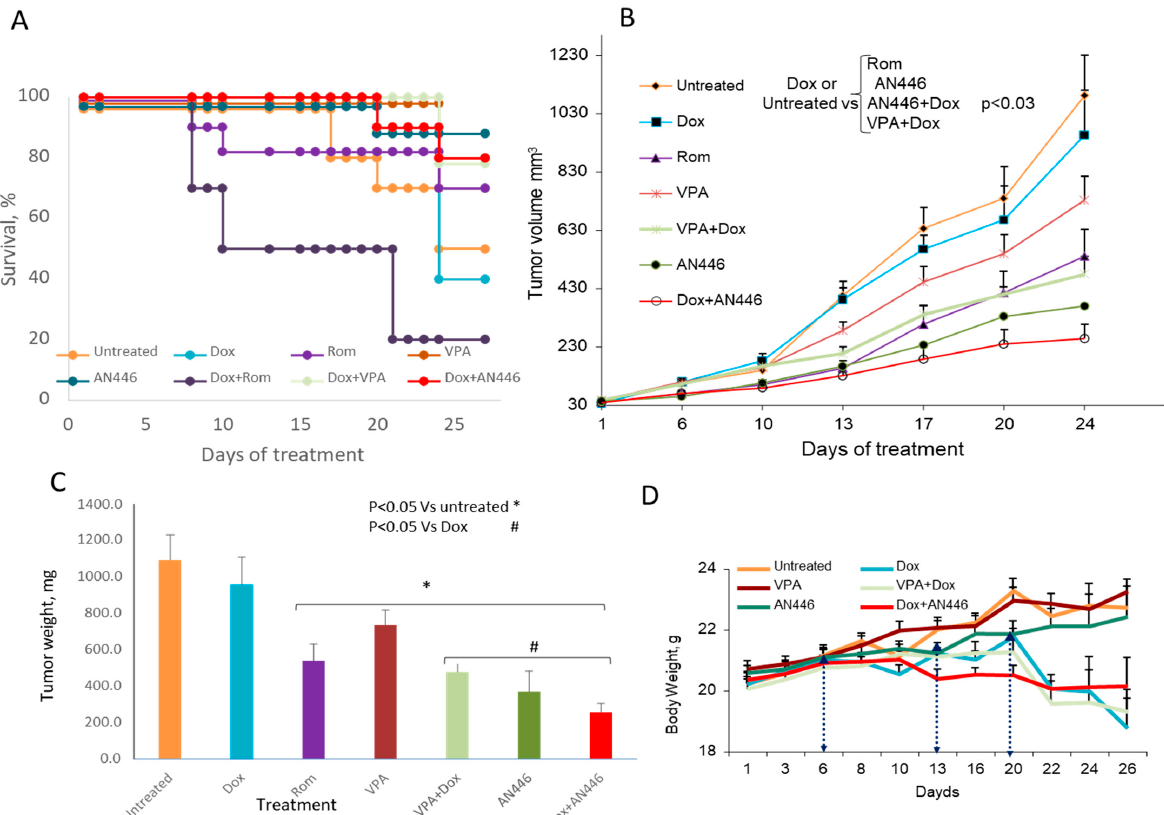
Figure 2. Effect of HDACIs, Dox, and their combinations in the 4T1 murine mammary carcinoma model. Eight ‐ week ‐ old BALB/c mice were inoculated sc with 5 × 10 4 4T1 breast cancer cells. When tumor volume reached 30–40 mm 3 , the mice were assigned blindly to the following treatments: saline ip ( n = 5) or po ( n = 5); 4 mg/kg ip Dox, once/week ( n = 10); 25 mg/kg po AN446 thrice/week ( n = 10); 2 mg/kg ip Rom the first week and 1 mg/kg the second and third weeks ( n = 10); 200 mg/kg po VPA thrice/week ( n = 10); 25 mg/kg po AN446 + 4 mg/kg ip Dox ( n = 10); 2 mg/kg ip Rom the first week and 1 mg/kg the second and third weeks. Rom doses were given with +4 mg/kg ip Dox ( n = 10); 200 mg/kg po VPA + 4 mg/kg ip Dox ( n = 10). The percent of surviving mice was assessed by a Kaplan–Meier graph ( A ). Tumor growth as a function of time (mean ± SE, mm 3 ) was plotted and its growth among groups was compared by one ‐ way ANOVA ( B ). The average tumor weight at the termination point is shown ( C ). Changes in average tumor weight along time lines, the time ‐ points ( D ). * Significantly changed from vehicle control; # significantly changed from Dox treatment.